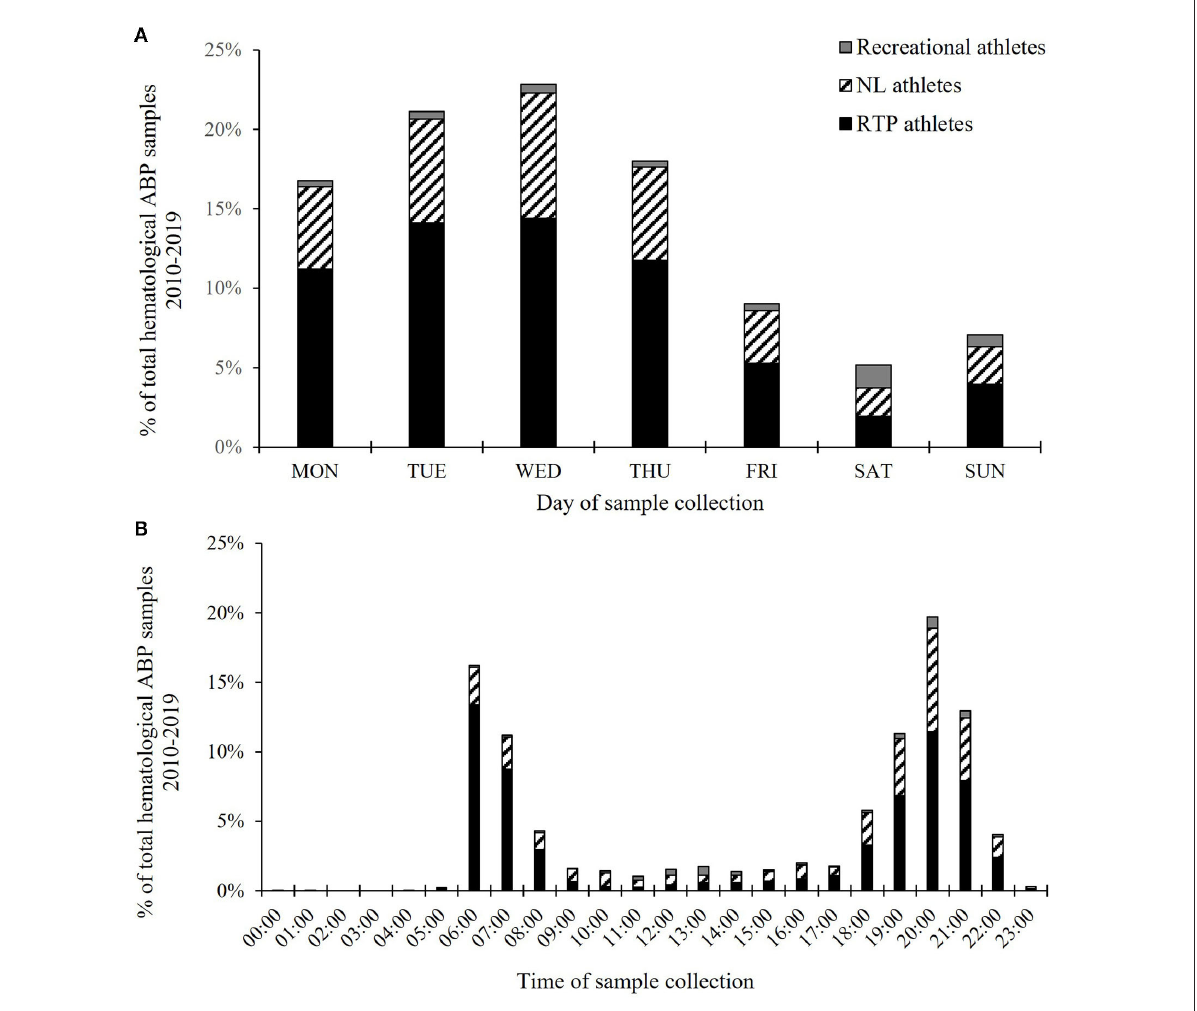
FIGURE2 Distribution of hematological ABP samples from Monday to Sunday (A) and during the day (B) in the period 2010–2019. RTP, Registered testing pool; NL, National level. Time of day data available for 5,491